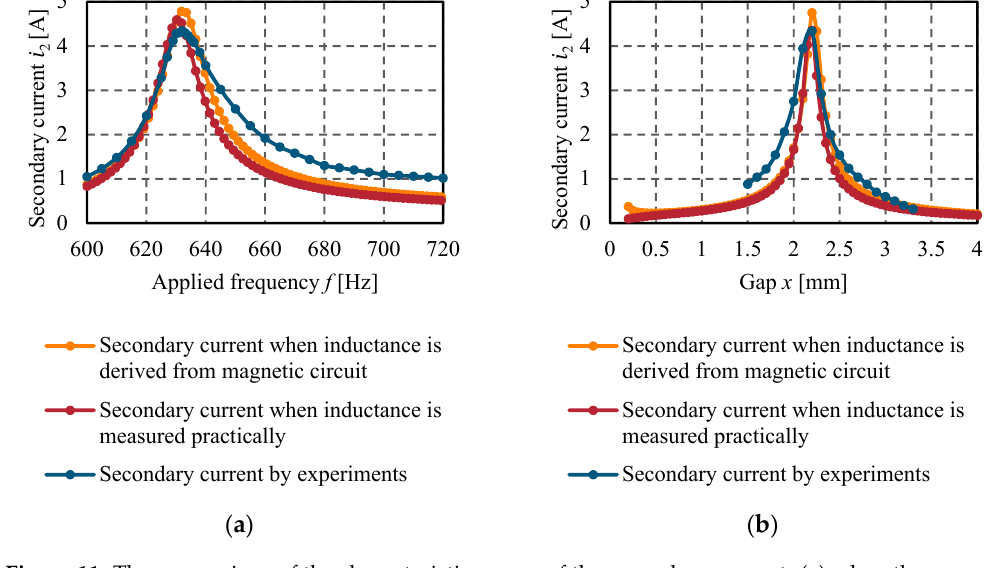
Figure 11. The comparison of the characteristics curve of the secondary current: ( a ) when the gap x is 2.0 mm; ( b ) when the applied frequency f is 650 Hz.